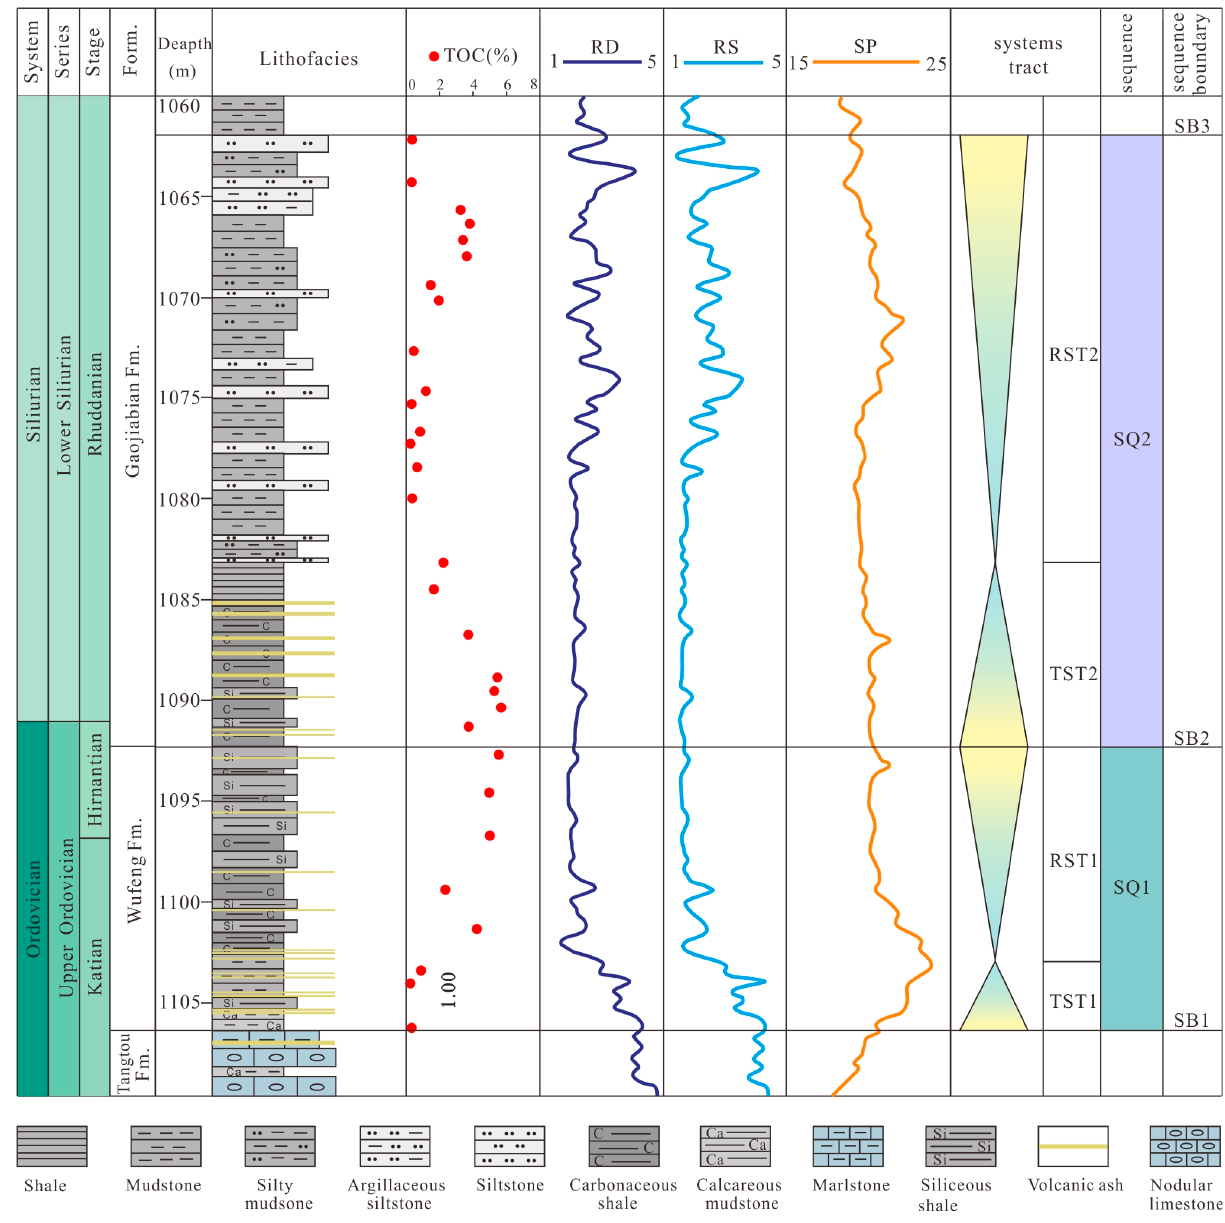
Figure 2. Sequence stratigraphic framework of the Lower Yangtze region during O/S transition based on lithology and well logs from Well